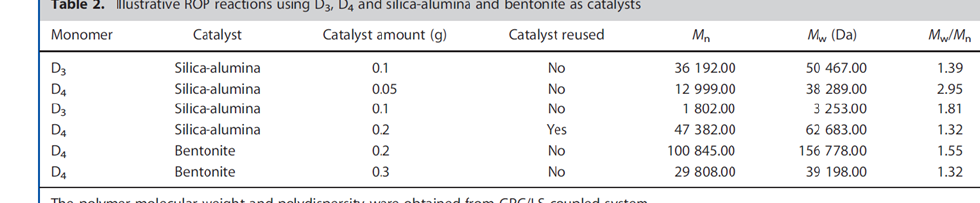
Figure 24. Chemical and textural properties of silica-alumina and bentonite before and after acid treatment (adapted with permission from Ref. [127]. 2012, Vallejo-Montesinos, J.)